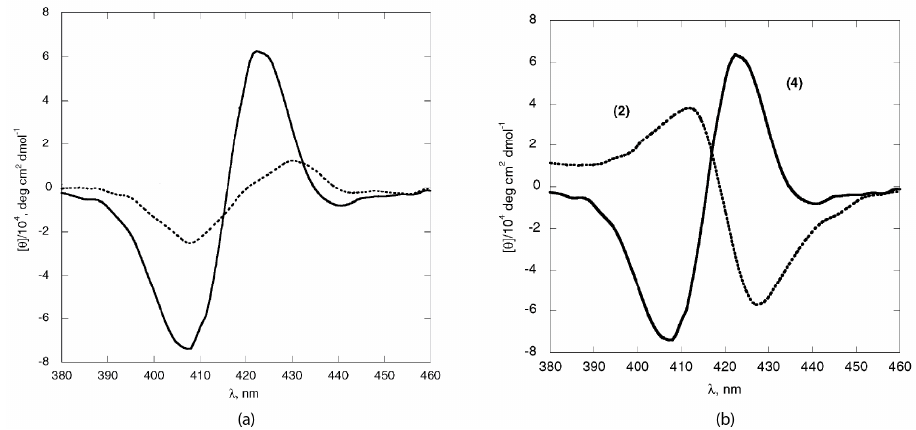
Figure 4. CD spectroscopic features of glycoporphyrins in EtOH/H 2 O mixture: ( a ) porphyrin 4 (3.4 µ M) in 40% EtOH (solid line) and EtOH 40%, NaBr 0.074 M (dashed line); ( b ) porphyrin 2 and 4 in EtOH 40%. Adapted with permission from [35]. Copyright 2008, The Royal Society of Chemistry.